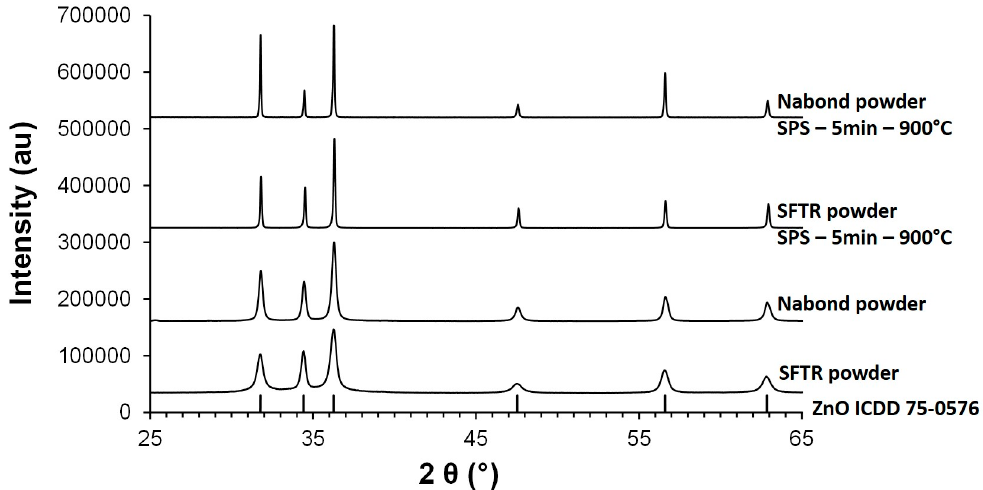
Figure 3. XRD patterns of ZnO nanopowder synthesized using the SFTR process, commercial Nabond nanopowder, and after sintering by Spark Plasma Sintering for 5 min at 900 °C.